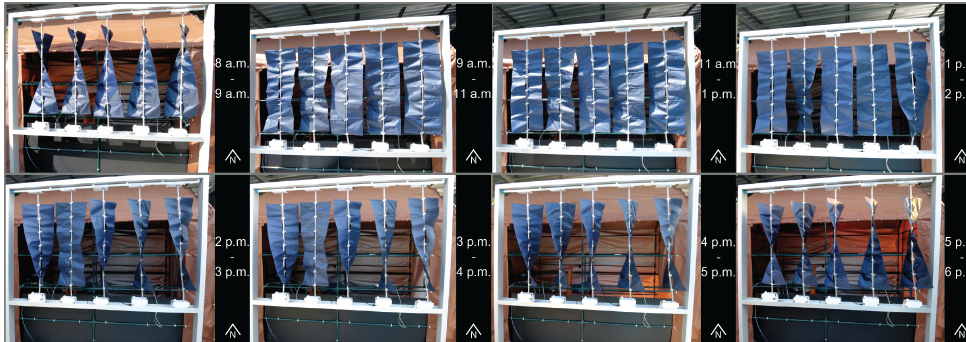
Figure 18. The kinetic façade version 2 movement in different time periods.